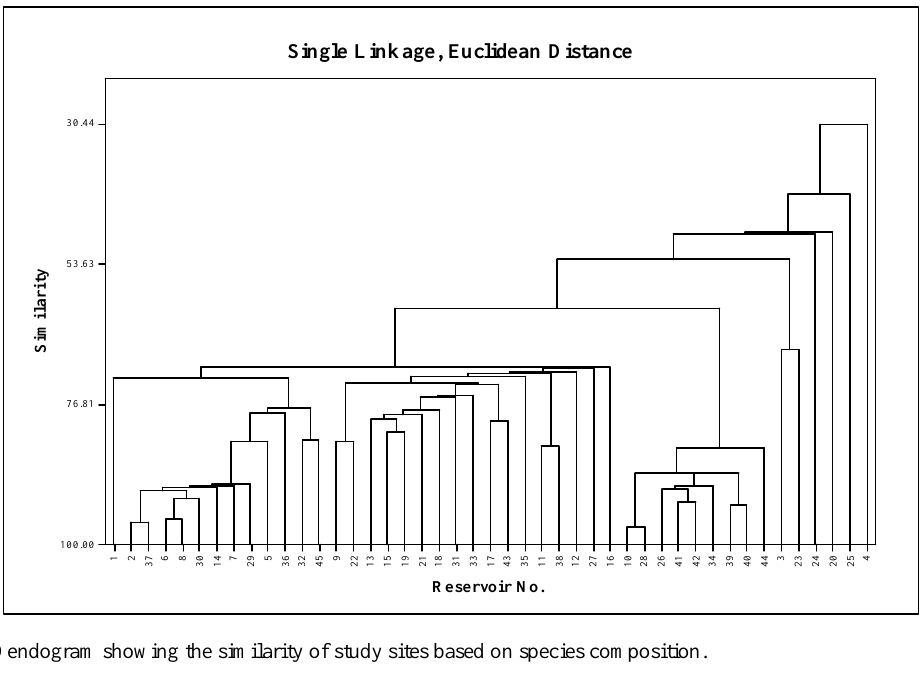
Figure 3: Dendogram showing the similarity of study sites based on species composition.